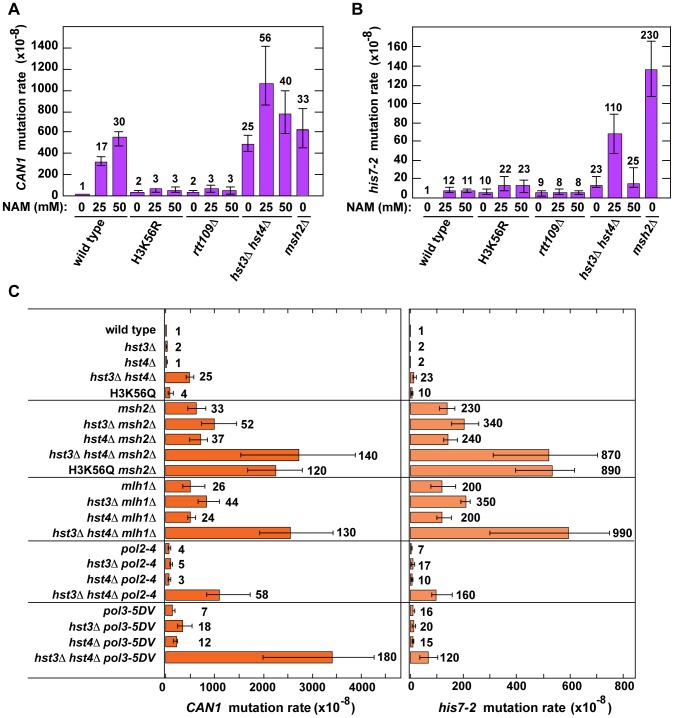
Involvement of H3 K56 deacetylation in the suppression of spontaneous mutagenesis in the yeast S. cerevisiae.Spontaneous mutation rates were measured as described in Materials and Methods. The data are shown as medians with 95% confidence intervals. The numbers above the bars are the relative mutation rates. (A) and (B) Effect of nicotinamide (NAM) on CAN1 (A) and his7-2 (B) mutation rates. The rates were measured in the haploid E134 strain (wild type) and indicated mutant derivatives exposed to 0-mM, 25-mM, or 50-mM NAM. (C) Effect of combining hst3Δ hst4Δ with msh2Δ, mlh1Δ, pol2-4, or pol3-5DV on spontaneous mutagenesis of CAN1 and his7-2.